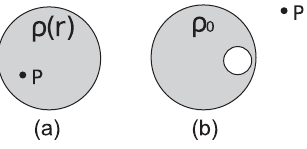
FIG. 1. Illustrations from CUE diagnostic questions. Students are asked not to solve the question, but to give ‘‘the easiest method you would use to solve the problem’’ (half credit) and ‘‘why you chose that method’’ (half credit). (a) ‘‘A solid non- conducting sphere, centered on the origin, with a non-uniform charge density that depends on the distance from the origin, e (cid:4) r 2 =a 2 . Find E (or V ) at point P .’’ (b) ‘‘A charged (cid:2) ð r Þ ¼ (cid:2) 0 insulating solid sphere of radius R with a uniform volume charge (cid:2) , with an off-center spherical cavity carved out of it. Find E (or 0 V ) at point P , at a distance 4 R from the